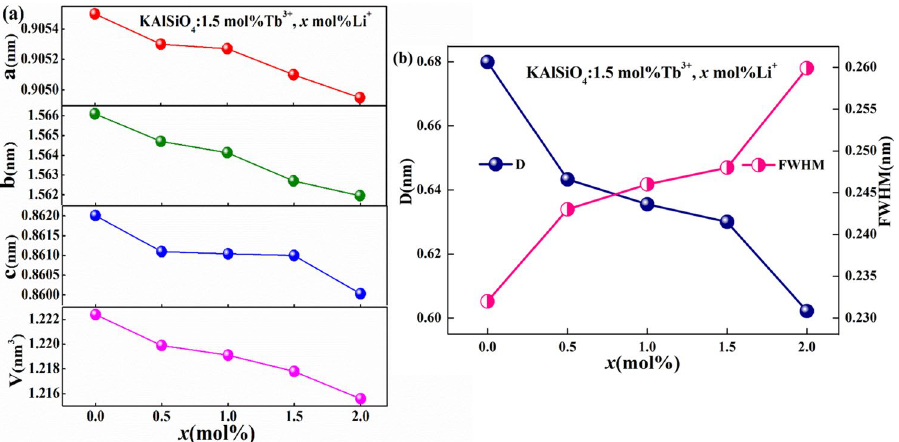
Figure 2. ( a ) Variation of the unit cell parameters with doping concentration ( x = 0,0.5,1,1.5,2) for KAlSiO 4 : 1.5 mol% Tb 3+ , x mol% Li + ( b ) The relationship between x , the grain size, and the (202) crystal plane FWHM in KAlSiO 4 : 1.5 mol% Tb 3+ , x mol% Li +